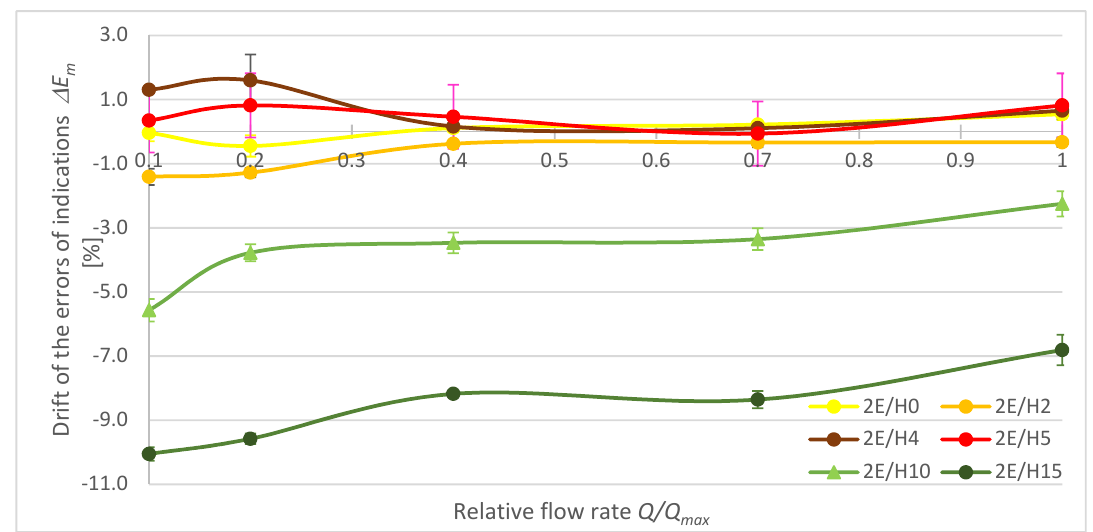
flow rate ( Q/Q max ).